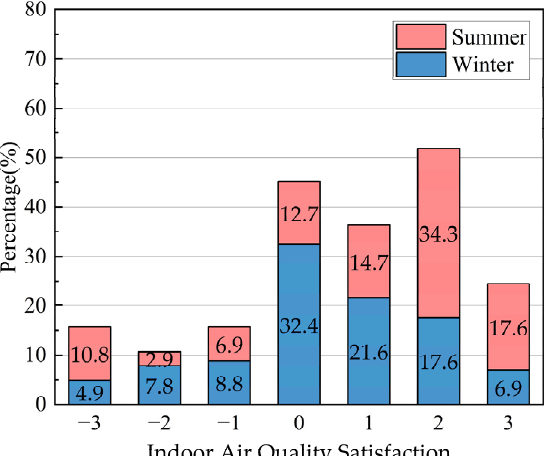
Figure 16. Indoor air quality satisfaction distribution of traditional houses in Xixinan Village.